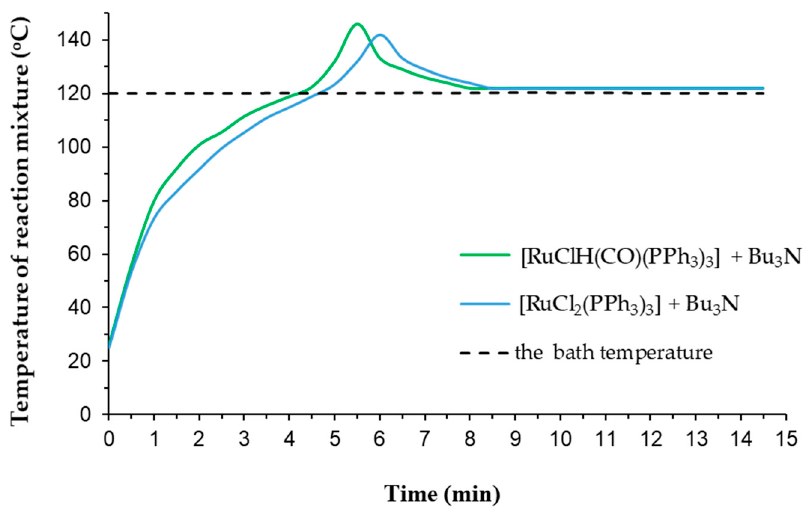
Figure 3. The changes of temperature of reaction mixture in the first step of the solvent-free reaction of hydroperoxide-free 4-allyloxybutan-1-ol with [RuClH(CO)(PPh 3 ) 3 ] + Bu 3 N and [RuCl 2 PPh 3 ) 3 ] + Bu 3 N (the reaction conditions: 150 mmol scale of allyloxyalcohol, [Ru] = 0.0005 mol% (5 ppm), Bu 3 N / [Ru] molar ratio = 50, argon atmosphere, magnetic